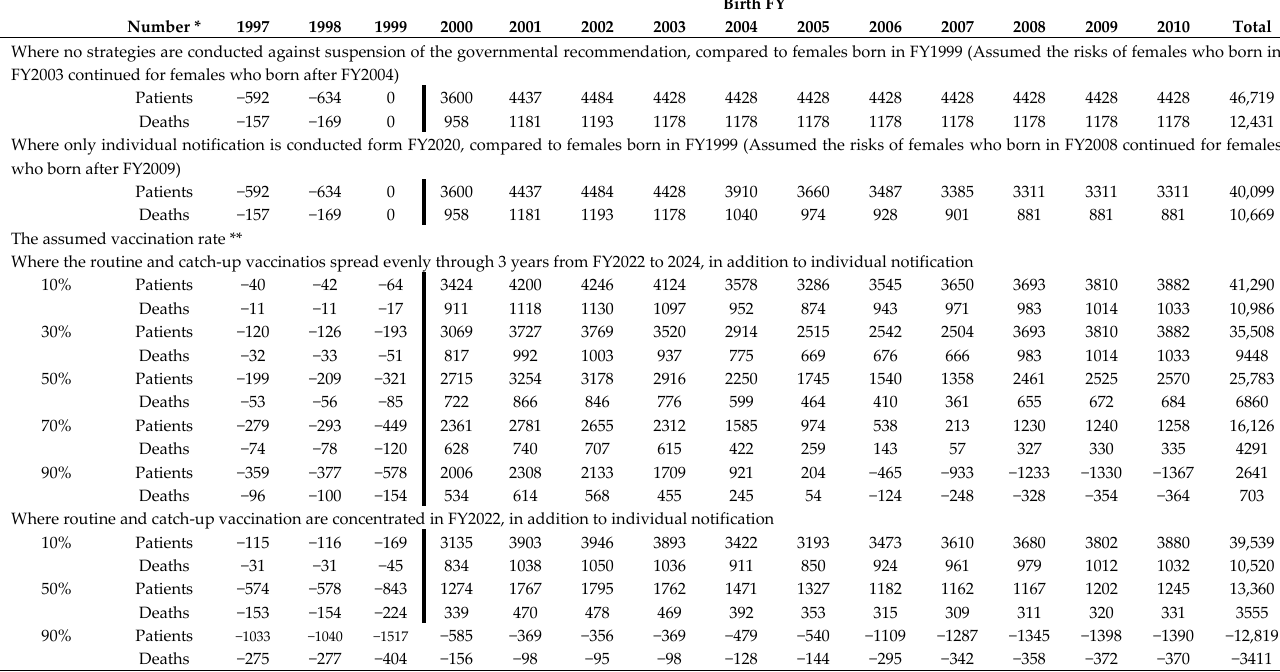
Bold lines: where the number of patients and deaths turn to decline. * The excess cases of incidence and death in each birth FY. ** The assumed vaccination rate means the vaccination rate for non- vaccinated females in FY2022 in each